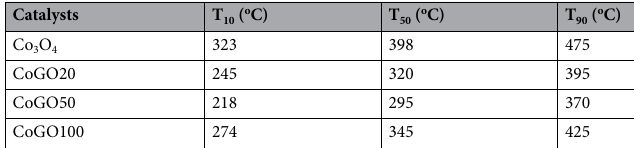
Table 2. Reaction temperature for obtaining 10%, 50%, 90% and 100% methane conversion (1 vol% CH 4 , 10 vol%